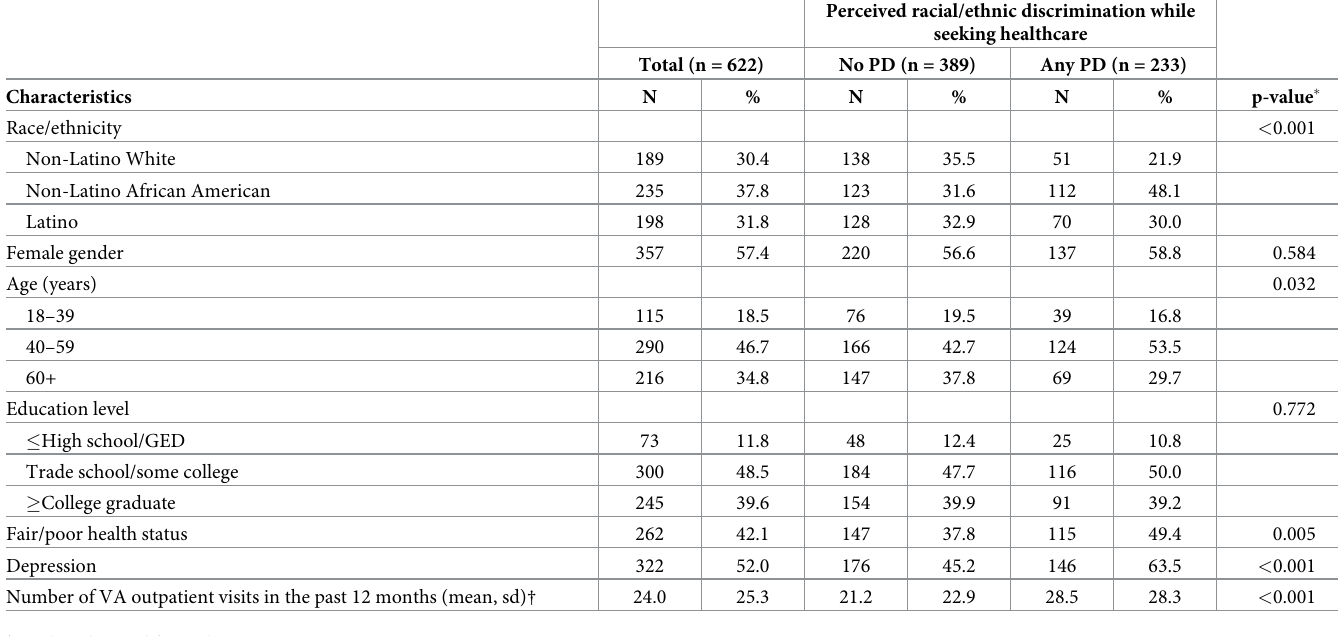
Perceived racial/ethnic discrimination while seeking healthcare Total (n = 622) Any PD (n = 233)